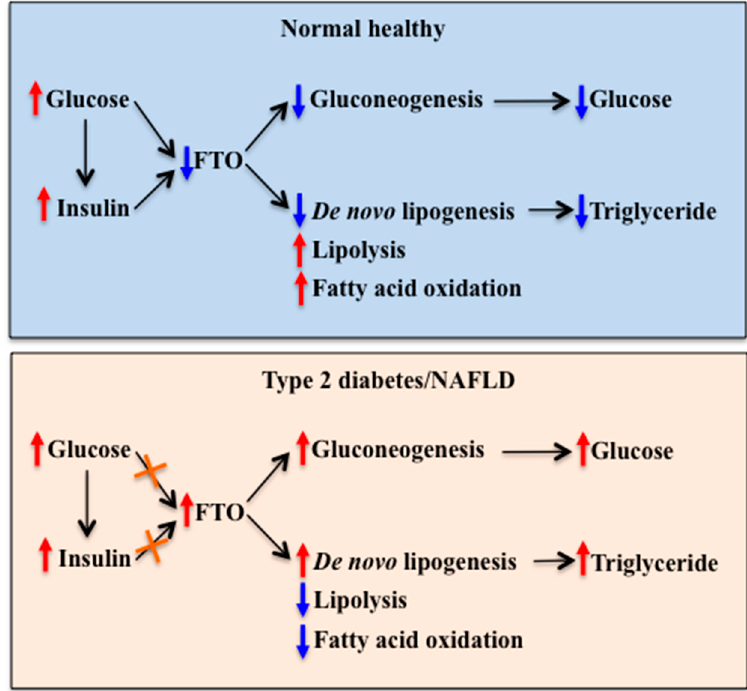
Figure 4. Role of FTO in the mediation of nutritional and hormonal regulation of hepatic glucose and lipid metabolism in health and diseases. Upper panel: In normal healthy individuals, increased blood glucose and insulin levels inhibit FTO expression in the liver. Reduced hepatic FTO expression inhibits gluconeogenesis, leading to reduced hepatic glucose production. It also inhibits de novo lipogenesis, while stimulates lipolysis and fatty acid oxidation, leading to reduced triglyceride deposition in the liver. Lower panel: In individuals with type 2 diabetes or NAFLD, impairments in glucose and insulin regulation of FTO expression may cause an increase in hepatic FTO expression. Increased hepatic FTO expression stimulates gluconeogenesis and de novo lipogenesis and inhibits lipolysis and fatty acid oxidation, leading to abnormally increased hepatic glucose production and triglyceride deposition. FTO: Fat mass and obesity-associated, NAFLD: Non-alcoholic fatty liver disease. Red arrow: Stimulation. Blue arrow: Inhibition. Orange cross: Impaired response.